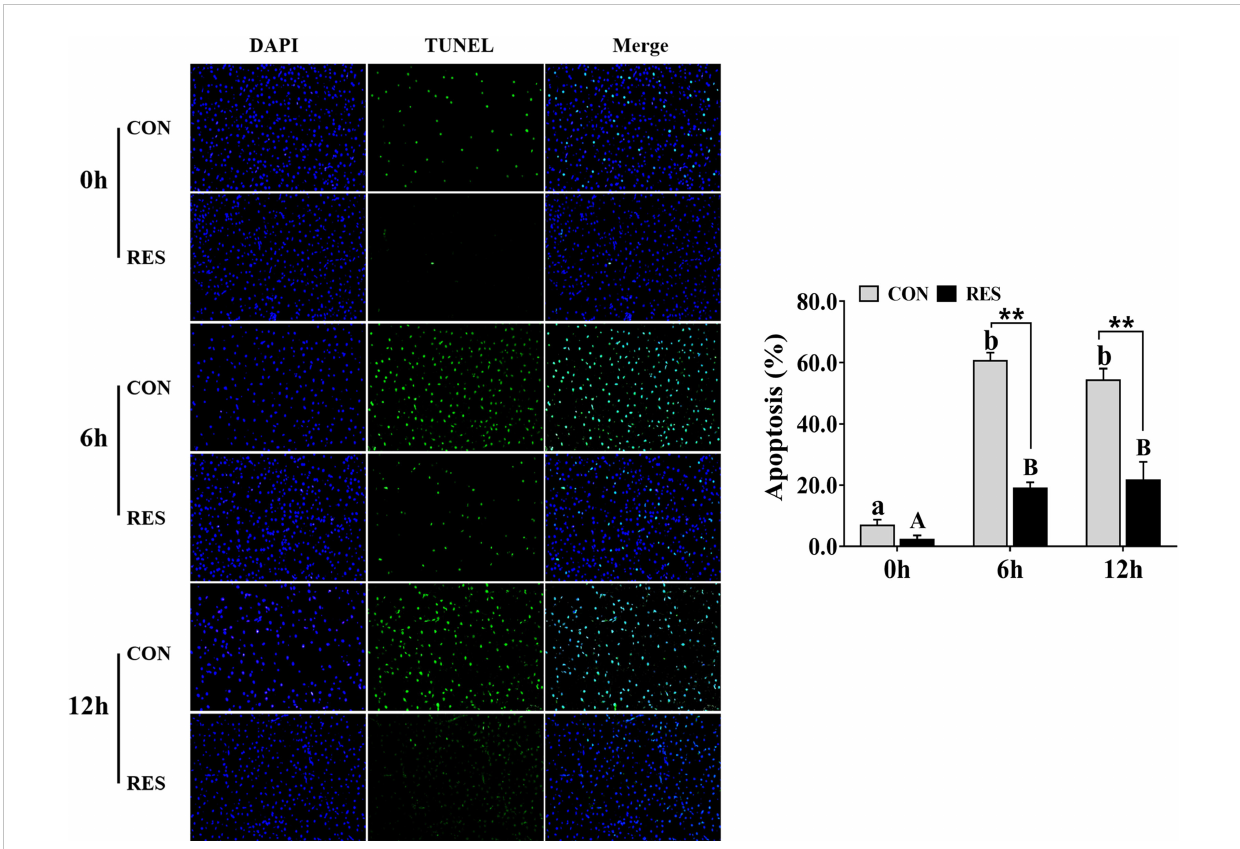
FIGURE 3 Effect of dietary RES on hepatocyte apoptosis in gibel carp at 6 h and 12 h after LPS injection. Data are mean ± SEM (n = 6). The lowercase letters represent signi fi cant differences among diverse LPS durations in the CON group ( P < 0.05); the uppercase letters represent signi fi cant differences among diverse LPS durations in the RES group ( P < 0.05). ** ( P < 0.01) represents signi fi cant differences between the CON and RES